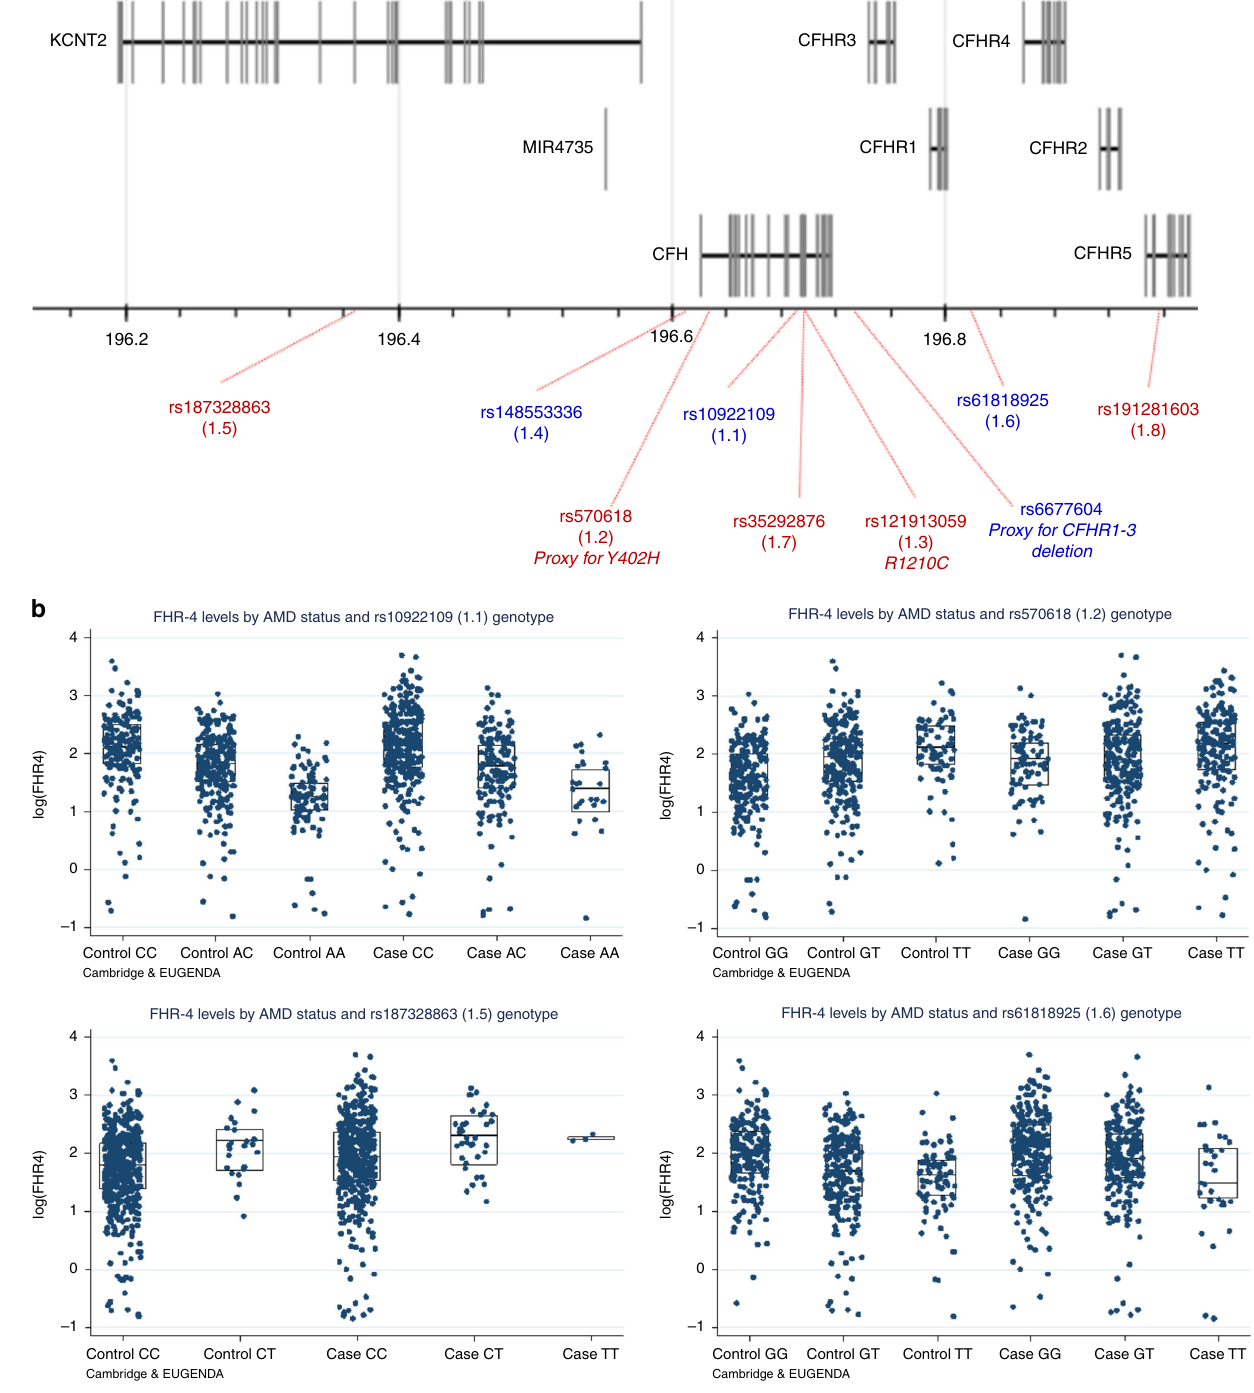
Fig. 3 Four AMD risk variants at the CFH locus are strongly associated with FHR-4 levels. Schematic diagram of chromosome 1 showing the genes in the CFH locus and the genomic location of the eight established AMD risk variants from the large IAMDGC GWAS of AMD 5 and rs6677604, a proxy for the previously reported AMD-protective CFHR1 – 3 deletion 29 ( a ). Variant annotations are in red or blue depending on whether the corresponding minor allele is AMD deleterious or protective. The rare missense variant rs121913059 (1.3; R1210C) was only present heterozygously in a case individual from the Cambridge cohort, and therefore was not included in the genetic association analyses with the FHR-4/FH levels. b shows box plots (and corresponding data points) of FHR-4 levels by AMD status and SNP genotype for the four variants that showed signi fi cant associations (after Bonferroni correction) with FHR-4 levels (Table 2), in the Cambridge and EUGENDA cohorts combined. Each box plot depicts median value (central line), fi rst quartile (lower bound line) and third quartile (upper bound line). Source data are provided as a Source Data fi